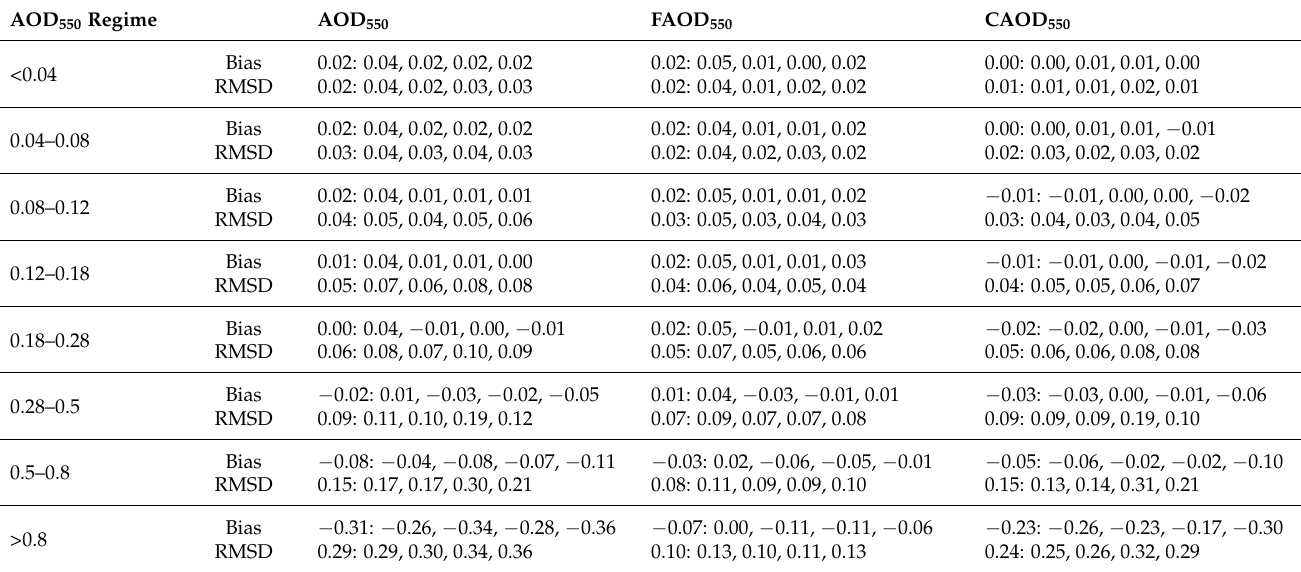
Table 3. Diagnostic mean bias and root mean square deviation (RMSD) for AOD 550 component by AOD 550 regime of individual ICAP C4C models. Included is the consensus mean bias followed by values from the four individual model members.